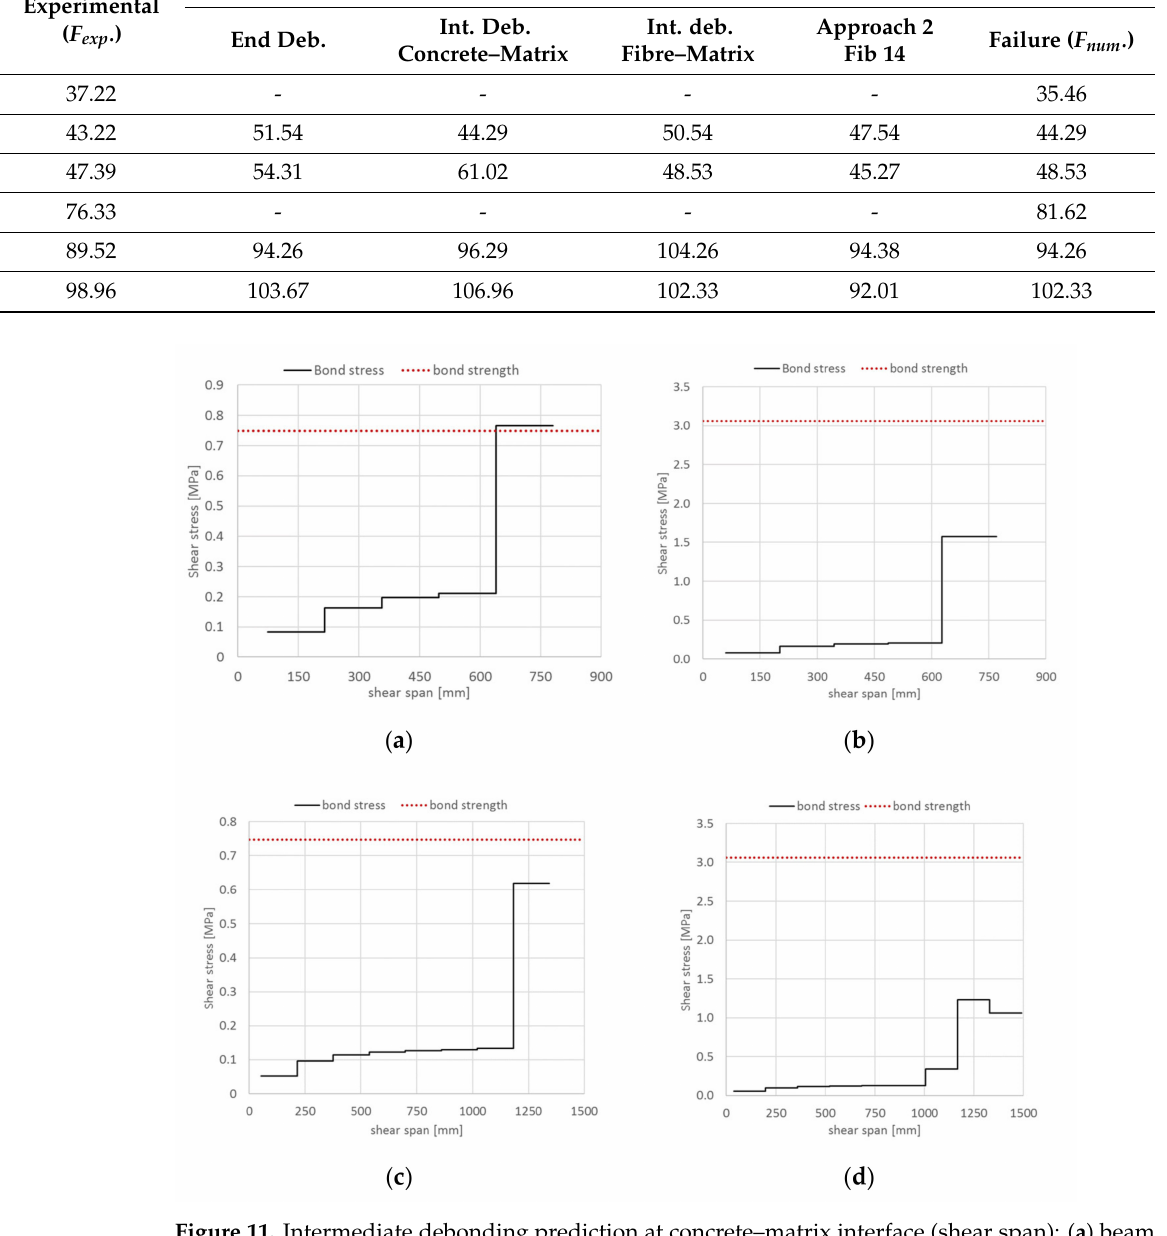
Figure 11. Intermediate debonding prediction at concrete–matrix interface (shear span): ( a ) beam A-EB; ( b ) beam A-IRS; ( c ) beam B-EB; ( d ) beam